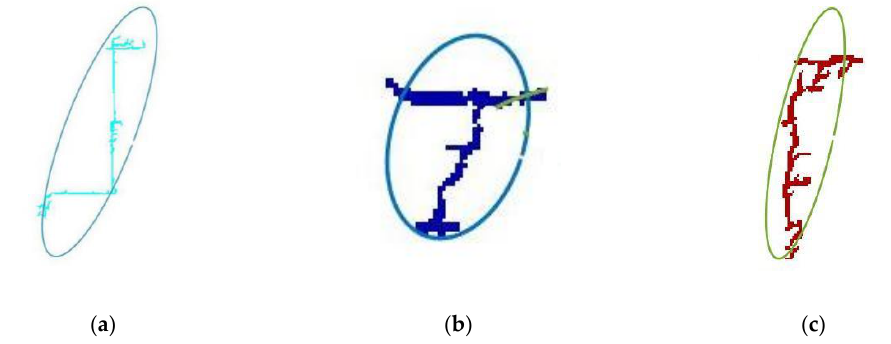
Figure 5. Sub-bands obtained by Haar transform on a rammed earth image. ( a ) Approximate edge map, ( b ) horizontal edge map, ( c ) vertical edge map and ( d ) diagonal edge map.